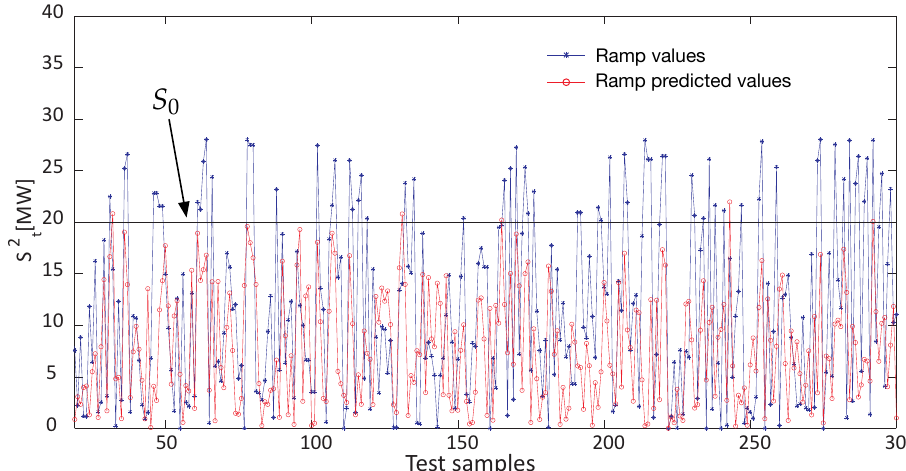
Figure 6. Estimation of the ramp function S 2 t ( Expression (2) ) obtained by the proposed method when using the ELM regressor, in Wind Farm B. The predicted series follows the measured series with RMSE ≈ 5.90 MW and MAE ≈ 4.40 MW, s (ramp) = 65.32% and s (no ramp) = 84.12% (see Table 5).